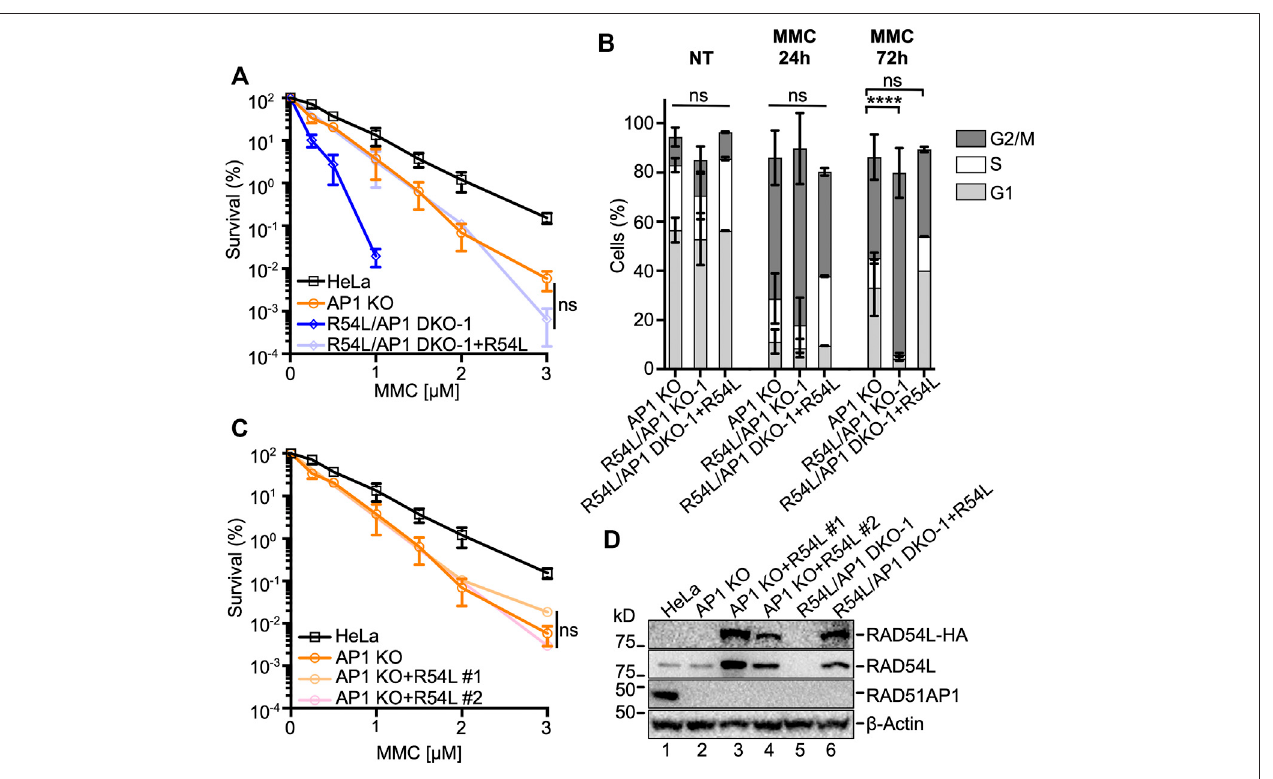
FIGURE2| EctopicexpressionofRAD54Lrescues RAD54L de fi ciencyin RAD54L / RAD51AP1 doubleKOcells,butdoesnotaltertheresponseof RAD51AP1 KO cellstoMMC. (A) ResultsfromMMCclonogeniccellsurvivalassaysofR54L/AP1DKO-1with(here:+R54L)andwithoutectopicRAD54LandofAP1KOandHeLacells for comparison purposes. Data points are the means from two independent experiments ±SD. ns, non-signi fi cant; two-way ANOVA followed by Tukey ’ s multiple comparisons test. (B) Average percentage R54L/AP1 DKO-1 cells with (here: +R54L) and without ectopic RAD54L and of AP1 KO cells (same data as in Figure 1D ) in G1, S and G2/M cell cycle phases without MMC (NT), and 24 and 72 h after release from MMC. Bars represent the means from two independent experiments±SD.****, p < 0.0001;ns,non-signi fi cant;one-wayANOVAfollowedbyDunnett ’ smultiplecomparisonstest. (C) ResultsfromMMCclonogeniccellsurvival assays of AP1 KO cells and two independently isolated AP1 KO clones expressing different amounts of ectopic RAD54L (D) . Data points are the means from two independentexperiments±SDforAP1KO+R54L#1cellsandfromthreetechnicalreplicatesforAP1KO+R54L#2cells.ns,non-signi fi cant;two-wayANOVAfollowed byTukey ’ smultiplecomparisonstest. (D) WesternblotsofwholecellproteinextractstoshowstablyexpressedectopicRAD54L-HA(here:+R54L)inAP1KOcells(lanes 3 and 4) and in R54L/AP1 DKO cells (lane 6). Loading control: β -Actin.